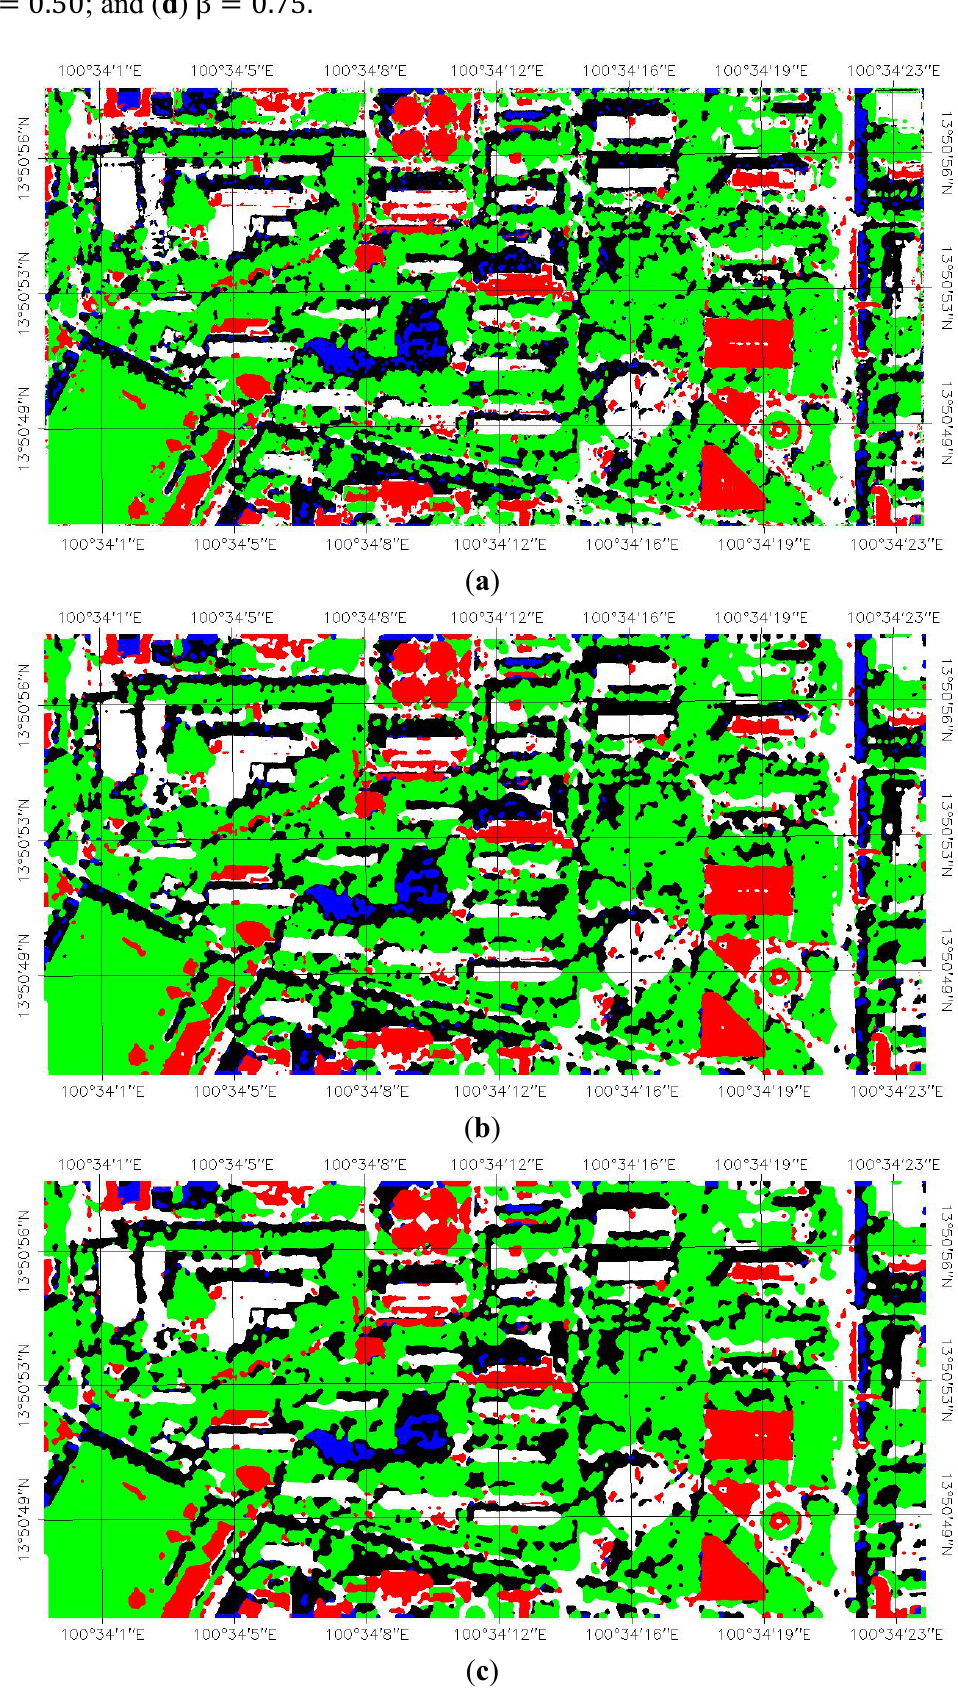
Figure 11. LCMs for the perfect registration case for ( a ) β (cid:3404) 0 ; ( b ) β (cid:3404) 0.25 ; ( c ) β (cid:3404) 0.50 ; and ( d ) β (cid:3404)